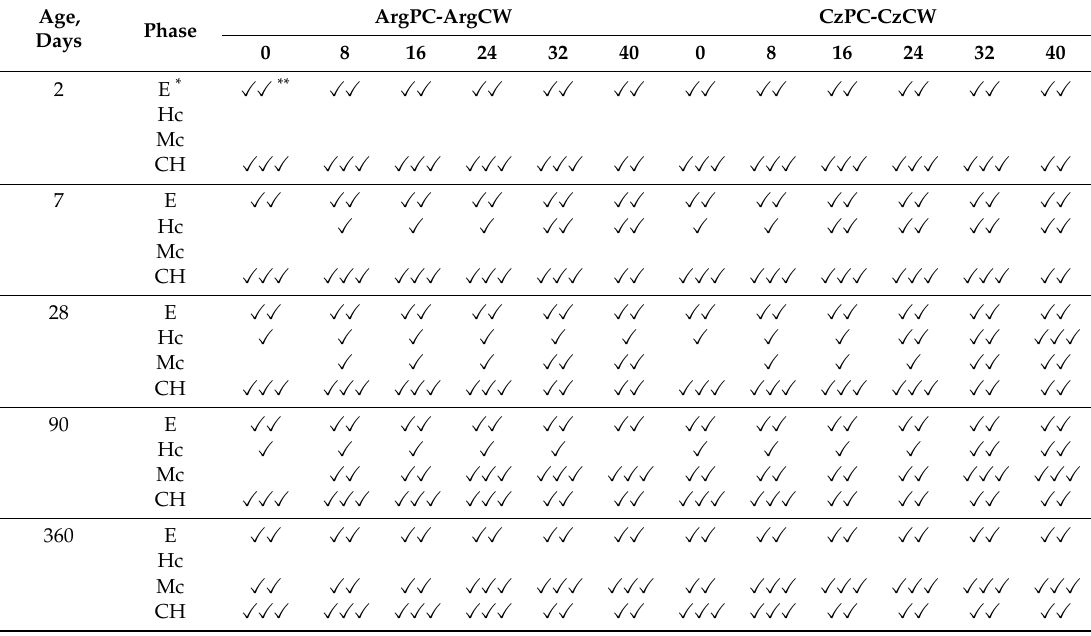
Table 5. Hydrated compound assemblage and main peak intensity determined by XRD for cement pastes.